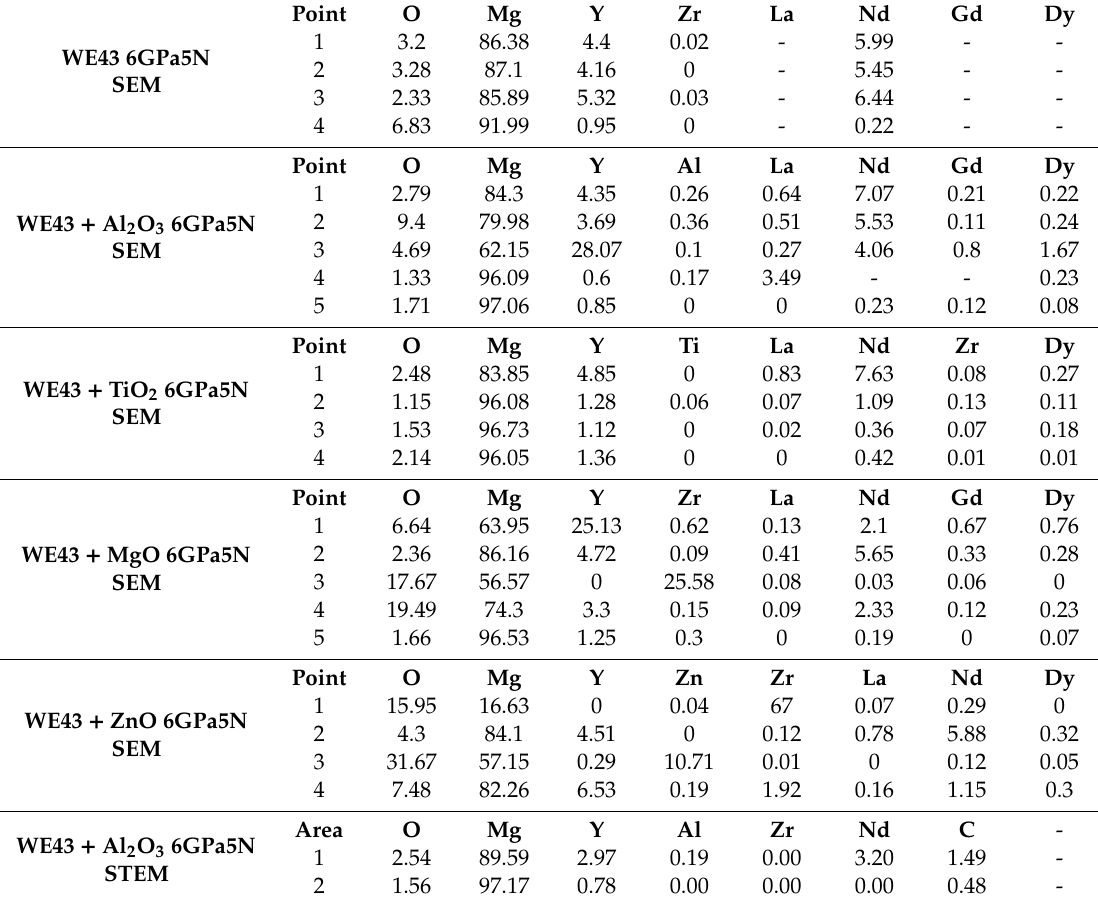
Table 1. Results of the energy dispersive X-ray analysis (EDX) (conducted in SEM and TEM) of second phase precipitates in the samples of pure WE43 [10] and modified with aluminum, titanium, magnesium, and zinc oxide after high-pressure torsion (HPT) as shown in Figure 1. The composition is given in